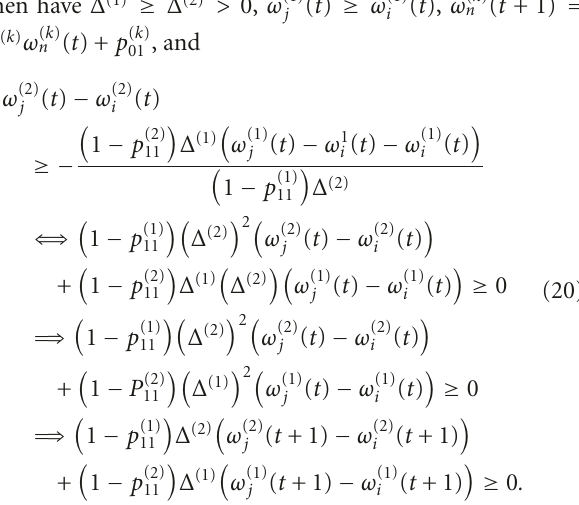
Figure 3: The performance of the myopic policy ( N = 3, L = 2, p (1) = 0 . 95, p (1) = 0 . 05, p (2) = 0 . 65, and p (2) 11 01 11